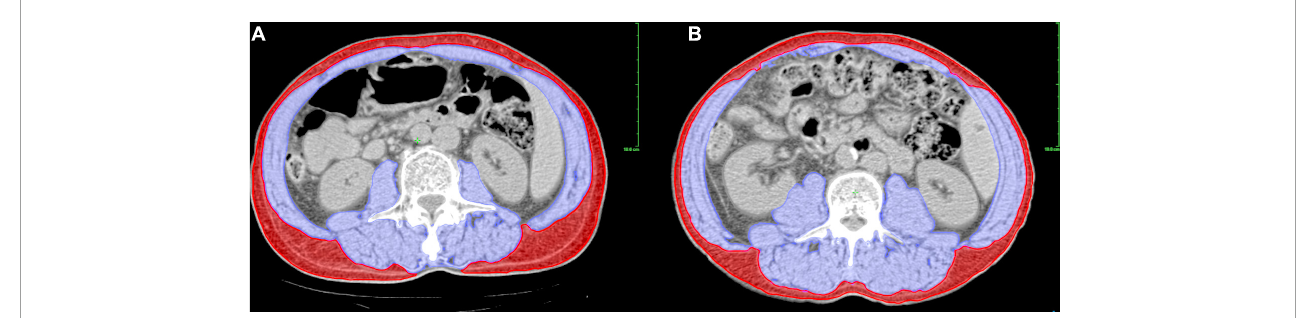
FIGURE1 Assessment of body composition parameters using a CT-based method at L3 level. The picture shows different sarcopenic statuses in patients with the same BMI, in which blue and red zones represent the skeletal muscle and subcutaneous adipose tissue, respectively. (A) A male patient with sarcopenia (SMI = 46.52 cm 2 /m 2 , BMI = 22.50 kg/m 2 ). (B) A male patient without sarcopenia (SMI = 56.19 cm 2 /m 2 , BMI = 22.50 kg/m 2 ). BMI, body mass index; CT, computed tomography; L3, third lumbar vertebra; SMI, skeletal muscle index.